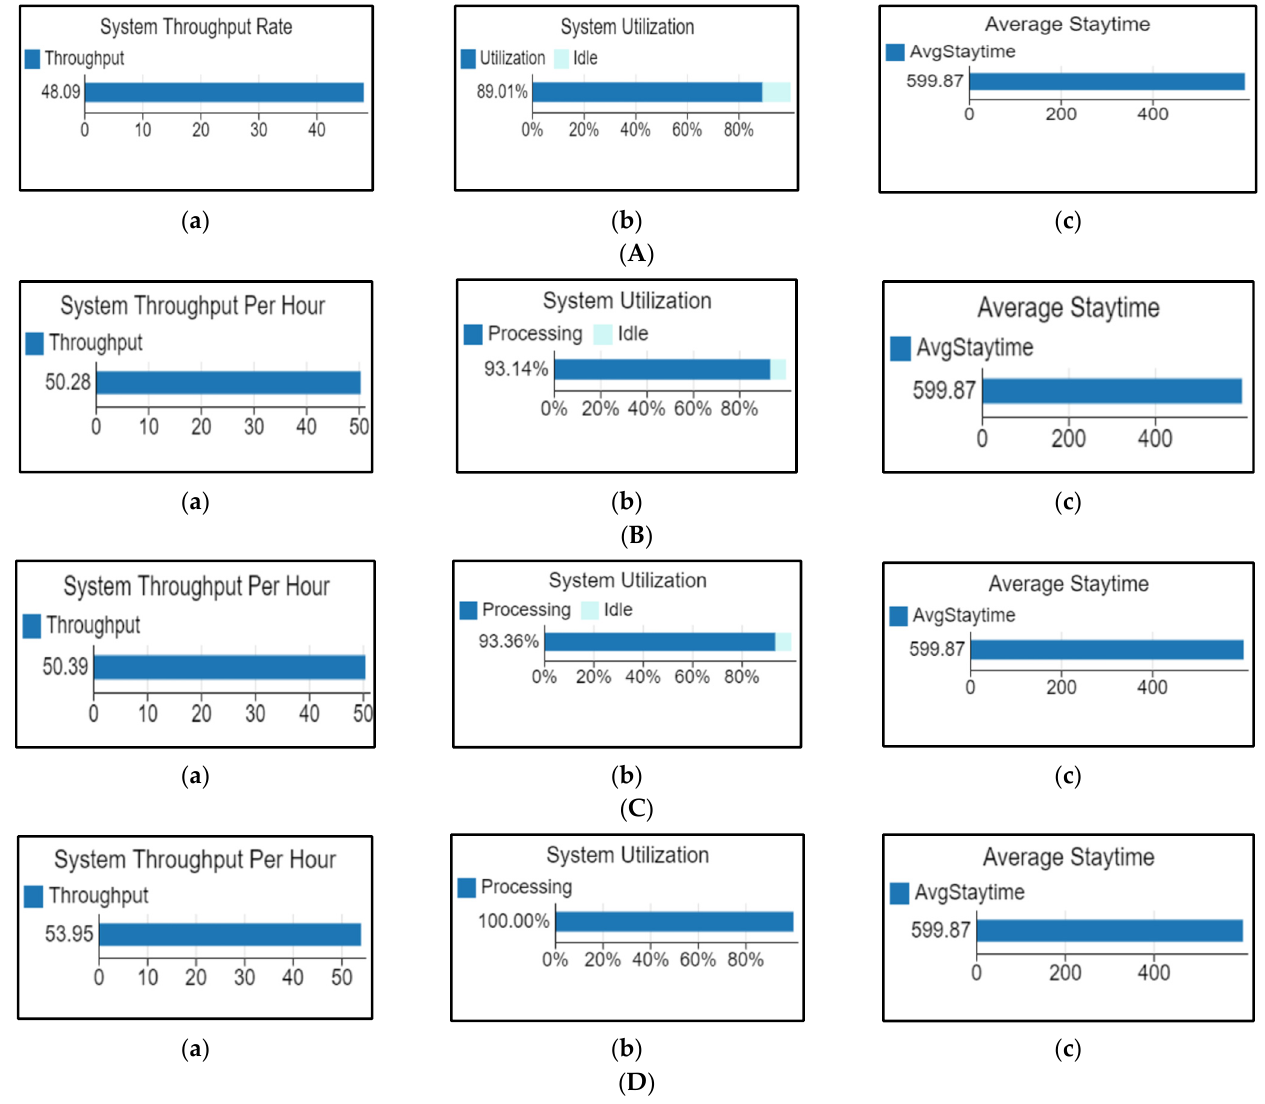
Figure 6. Simulation results by without breakdown of machines. ( A ) One-Degree Flexible System. ( a ) System Throughput rate. ( b ) System Use. ( c ) Average stay time. ( B ) Two-Degree Flexible System. ( a ) System Throughput rate. ( b ) System Use. ( c ) Average stay time. ( C ) Semi-Flexible System. ( a ) System Throughput rate. ( b ) System Use. ( c ) Average stay time. ( D ) Fully Flexible System. ( a ) System Throughput rate. ( b ) System Use. ( c ) Average stay time.